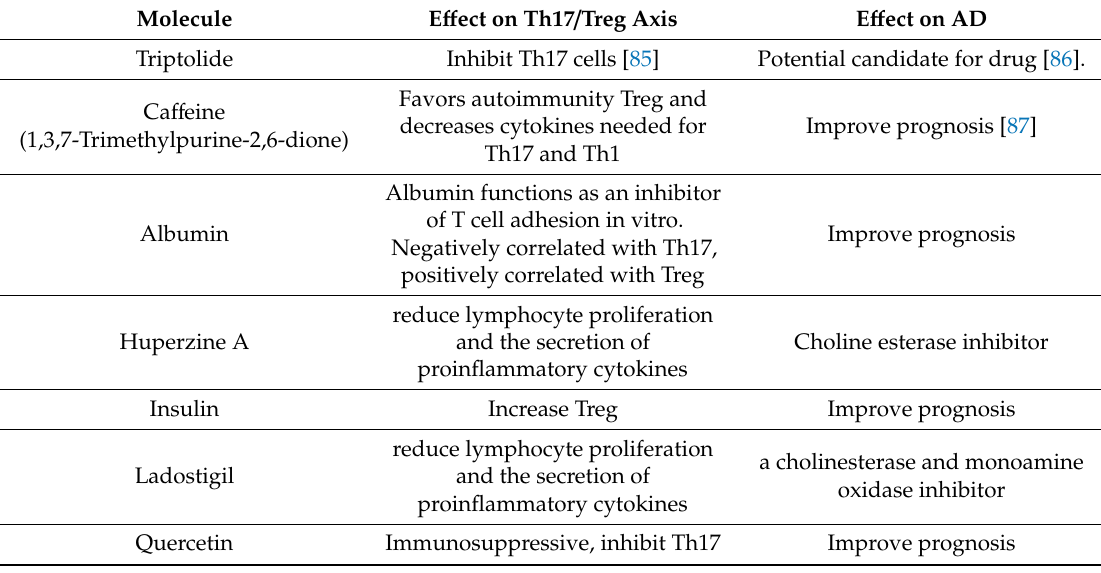
Table 10. Compounds that enhance AD prognosis and inhibit CD4 + Th17. Molecule E ff ect on Th17 / Treg Axis E ff ect on AD Inhibit Th17 cells [85] Potential candidate for drug